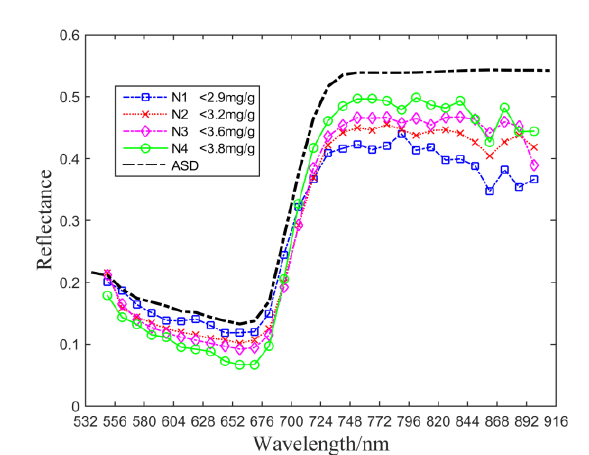
Figure 2 The spectra of rice leaf measured using HSL system and ASD under different nitrogen levels.